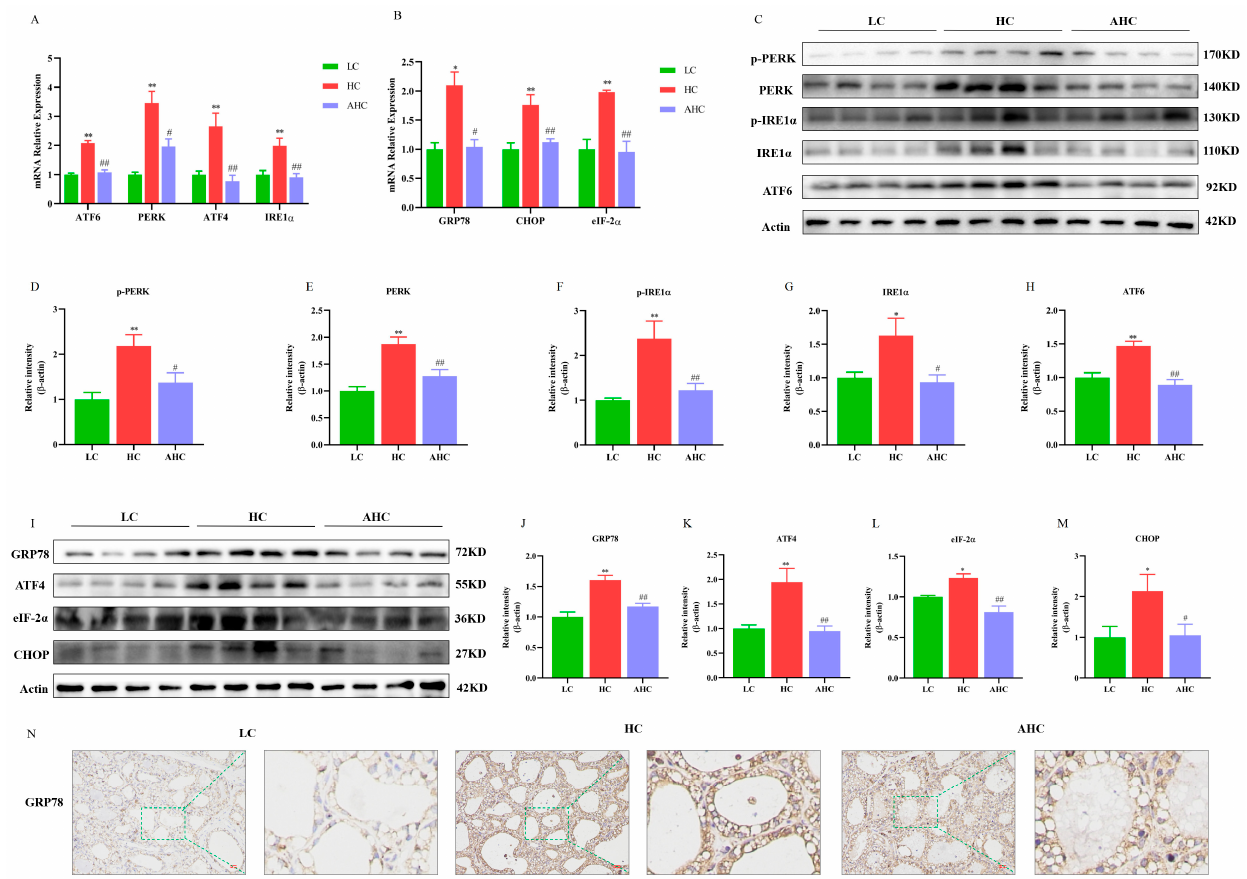
Figure 2. The effects of the high-concentrate diet supplemented with disodium fumarate on endo- plasmic reticulum stress in the mammary gland tissue of Hu sheep. Relative mRNA expression of endoplasmic reticulum stress-related genes in the mammary gland tissue of Hu sheep ( A , B ); representative bands of endoplasmic reticulum stress-related proteins in the mammary tissue of Hu sheep ( C , I ). Relative protein abundances of PERK, p-PERK, IRE1 α , p-IRE1 α and ATF6 ( D – H ); relative protein abundances of GRP78, ATF4, eIF-2 α , and CHOP ( J – M ); immunohistochemical results of GRP78 in mammary gland tissue of Hu sheep. The bar = 100 μ m ( N ). Data are presented as the relative protein abundances relative to actin (means ± SEM), * p < 0.05, ** p < 0.01 represent significant differences compared with the LC diet. # p < 0.05, ## p < 0.01 represent significant differences com- pared with the HC diet; immunohistochemical results of GRP78 in the mammary gland tissue of Hu sheep (200× magnification). The red bar = 100 μ m ( N ) The green line represents zooming in on the selected area of the image.